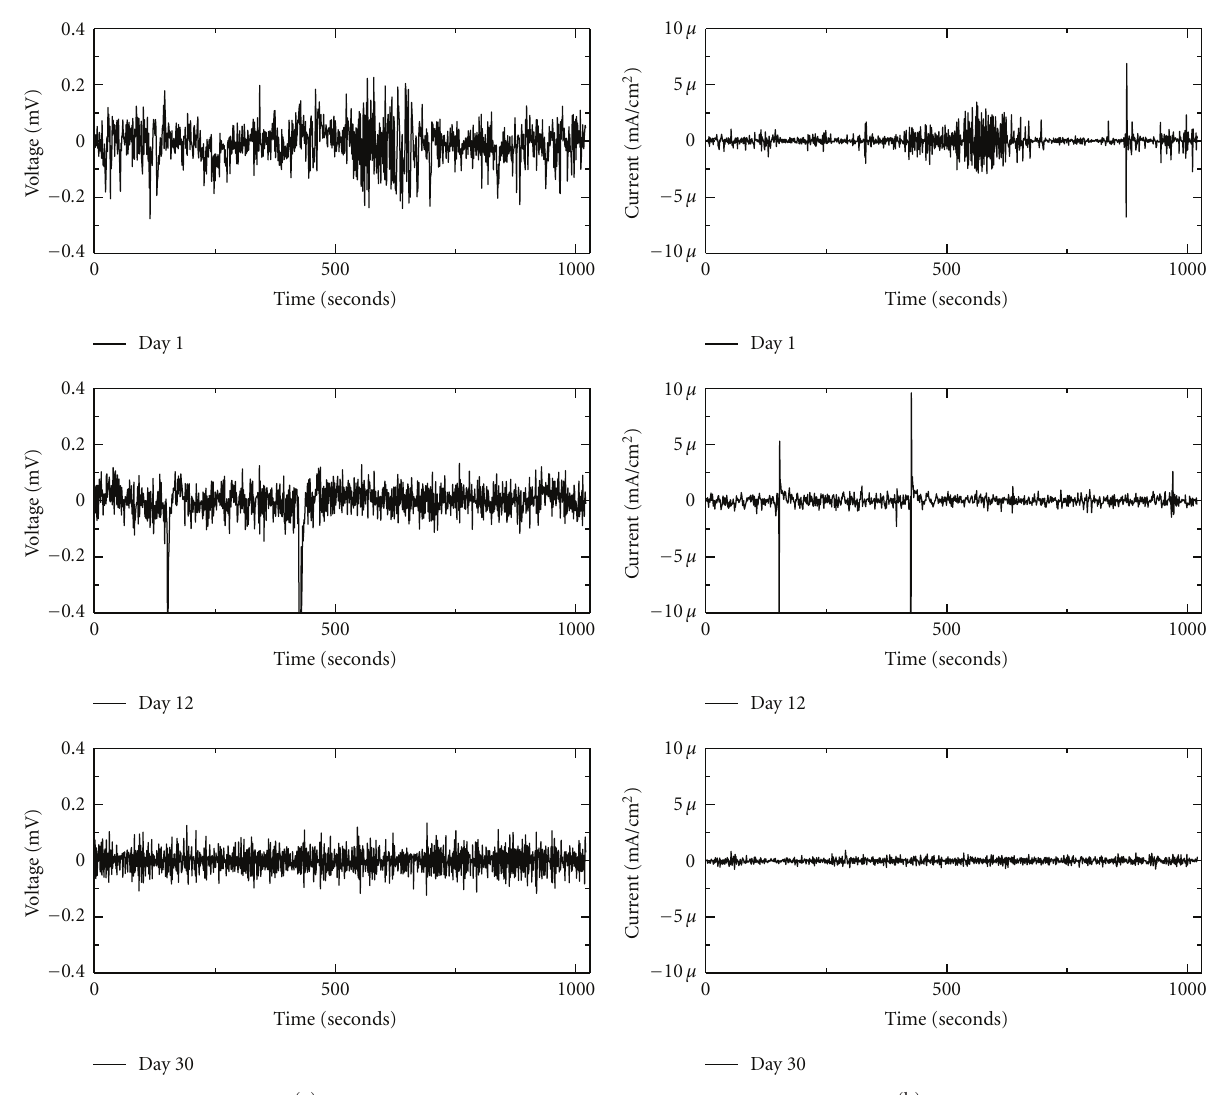
Figure 1: Electrochemical potential and current time series for di ff erent